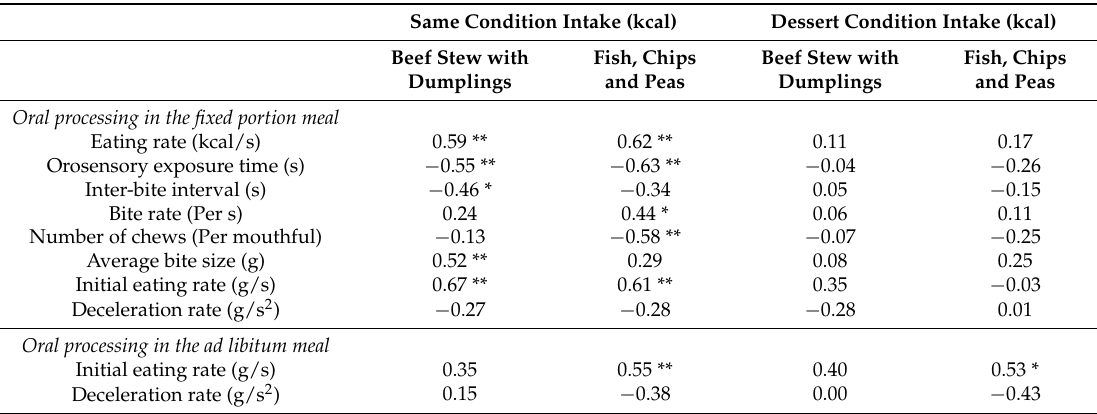
Table 7. Relationships (Pearson’s) between ad libitum intake (kcal) and measures of oral processing in the fixed-portion and the ad libitum meals.